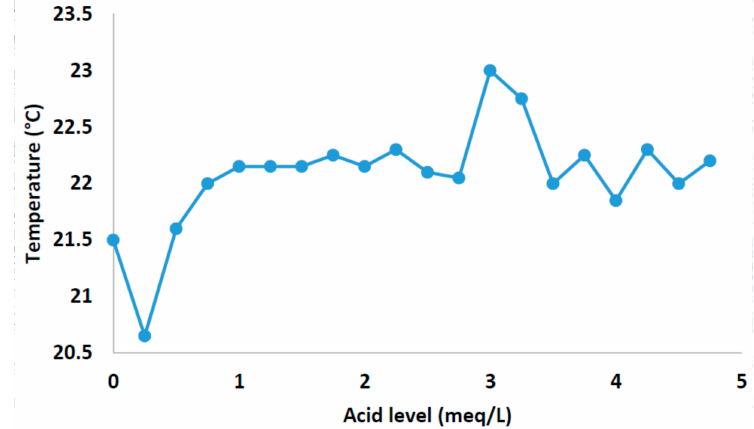
Figure 6. Data collected on node